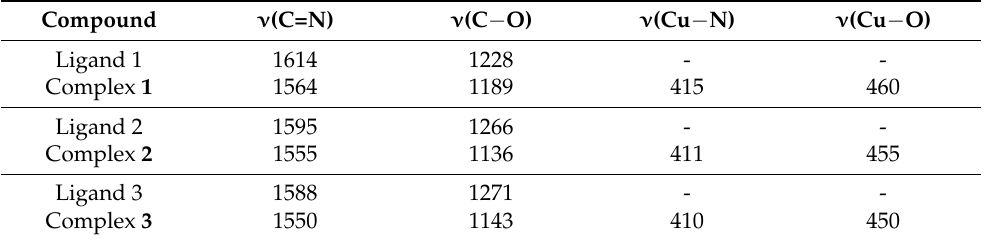
Table 2. Selected IR values (in cm − 1 ) of the Schiff bases and copper(II) complexes.